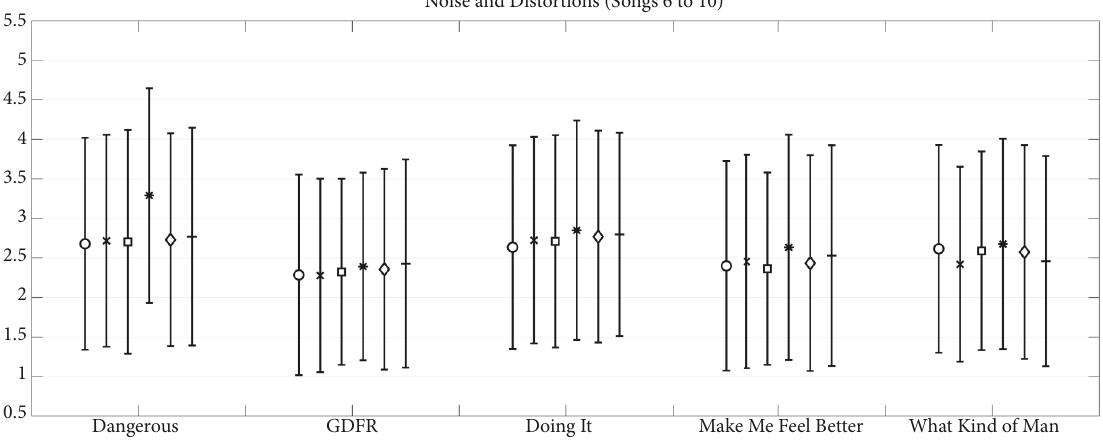
Figure 3: Noise and distortions results (songs 6 to 10). A score of 1 represents imperceptible noise and distortions and a score of 5 represents perceptible noise and